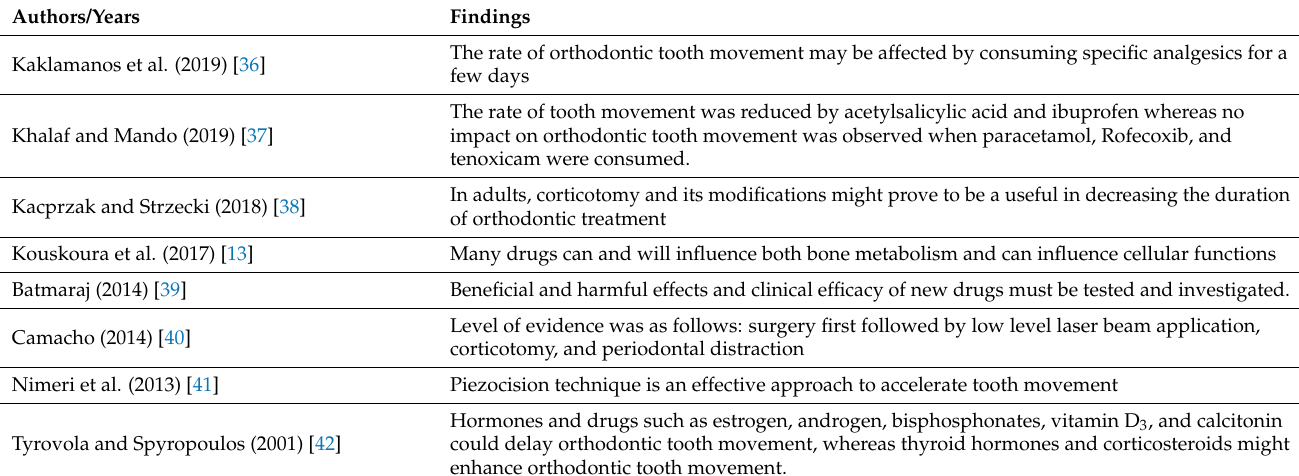
Table 4. The summary of review concerning papers on the relation between calcitriol and orthodontic treatment.